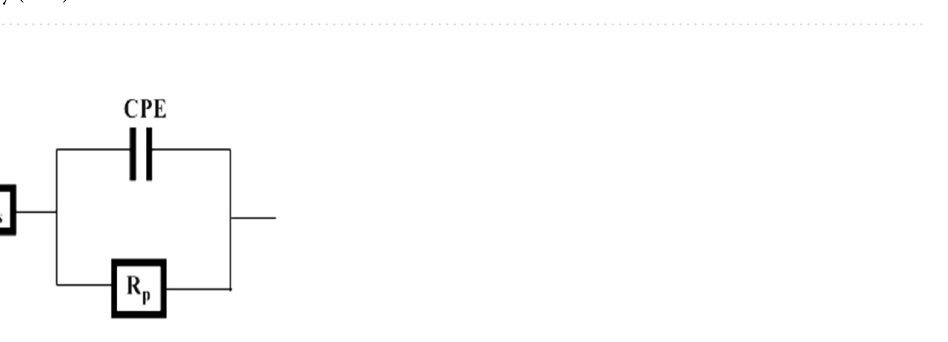
Figure 8. Equivalent circuit for welded steel uncoated and coated with Epoxy /Alumina composites at different concentration in 1 M HCl